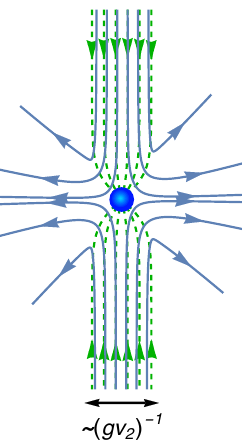
Figure 3 . A schematic picture of the QED magnetic flux induced by the bead solution through the kinetic mixing term (blue solid lines). The dark magnetic flux is shown by the green dashed lines. In the QED magnetic flux follows the dark magnetic flux inside the strings. The QED magnetic flux leaks out from around the dark magnetic monopole, i.e., | z | ∼ ( gv Bianchi identity of the U(1) gauge